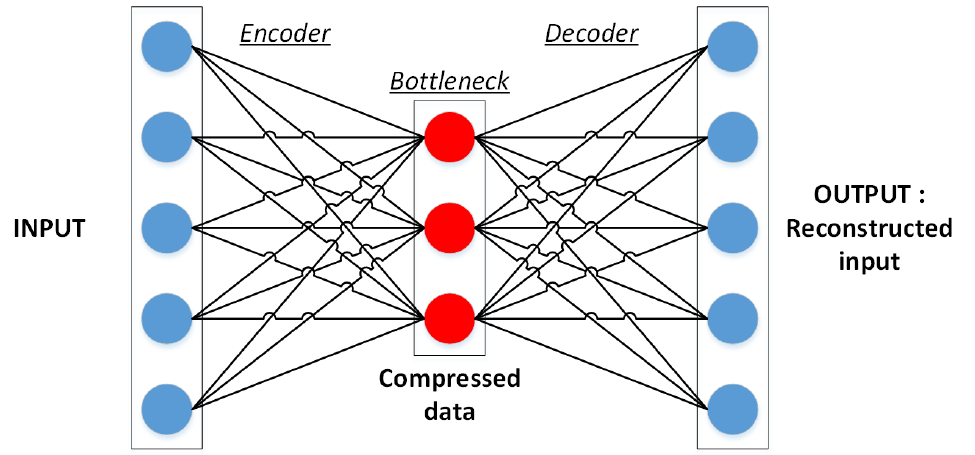
Figure 3. Basic architecture of a single layer autoencoder made of an encoder going from the input layer to the bottleneck and the decoder from the bottleneck to the output